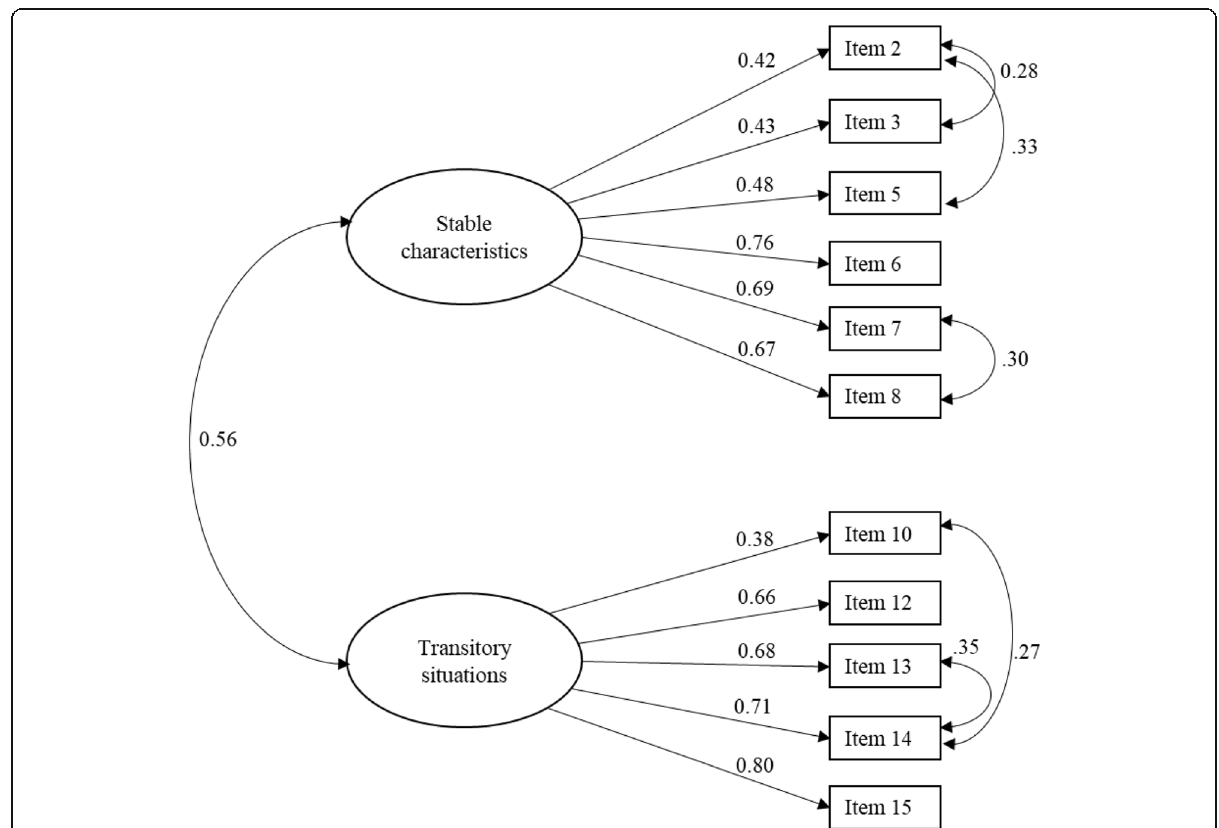
Fig. 2 Confirmatory factor analysis of the SBPP — phase IV. CFI = 0.93, SB χ 2 (38, n = 361) = 123.87, p = 0.00, RMSEA = 0.080 (00.07 – 0.10), TLI = 0.90, SRMR =